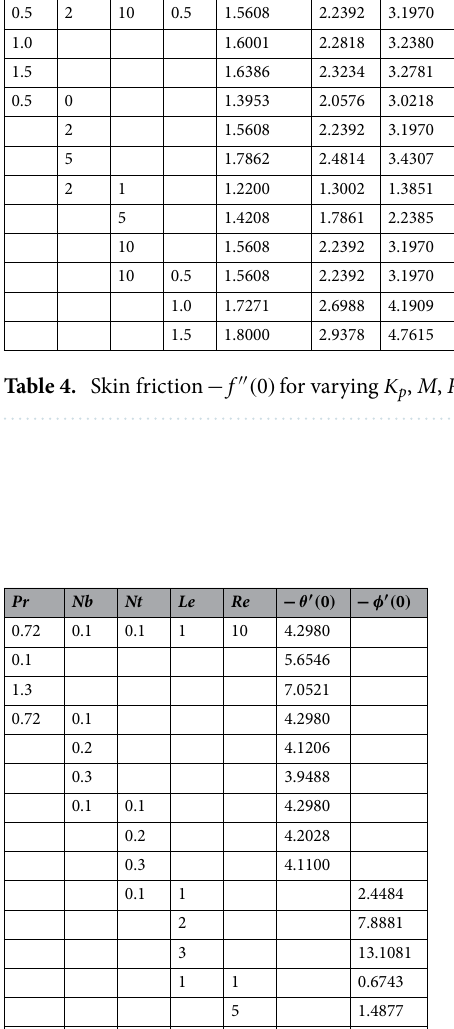
Table 5. Nusselt number